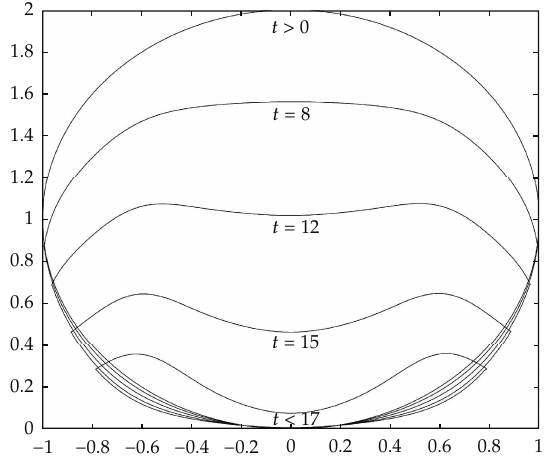
Figure 3: Shapes that the vessel takes at di ff erent times as it collapses with a cardioidal-like shape, in the